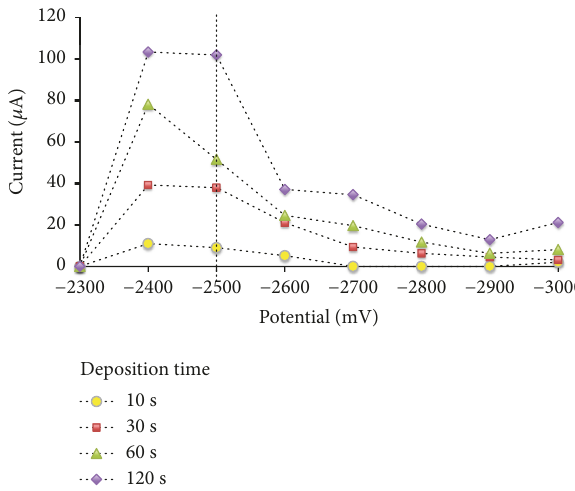
Figure 2: Investigation of sweep/scan rate for differential pulse delivery,50 𝜇 g/LBa,0.02MKClelectrolytewith5mg/LHg(0.0015M HNO 3 ), t dep = 60 sec, dp= -2500 mV. The dotted line indicates the optimumrateforBa.Although50mV/sproducedhigherpeaks,they were poorly resolved compared with peaks generated at 100 mV/s due to higher noise in the baseline.